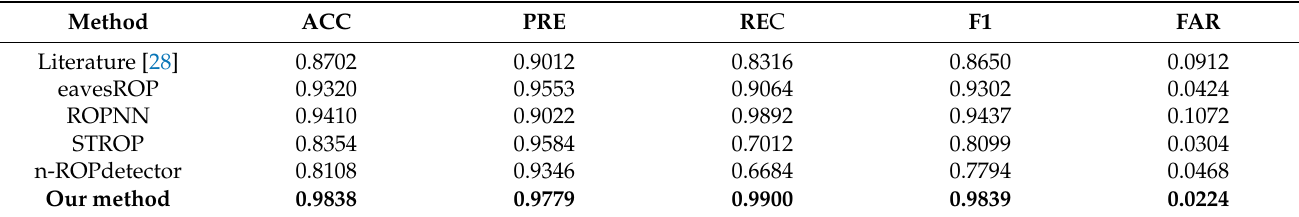
Table 3. Effectiveness comparison with baselines.